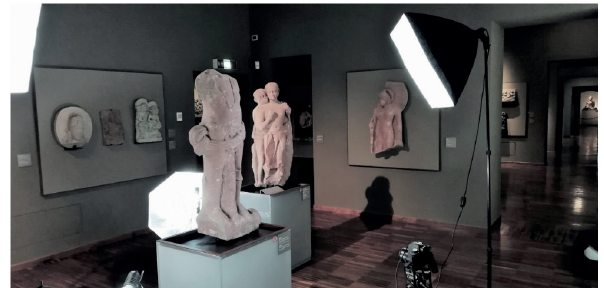
Figure 2 . Photographic set in the hall of Indian art at MAO. On the left the Yaksha, on the right in background the standing Buddha of